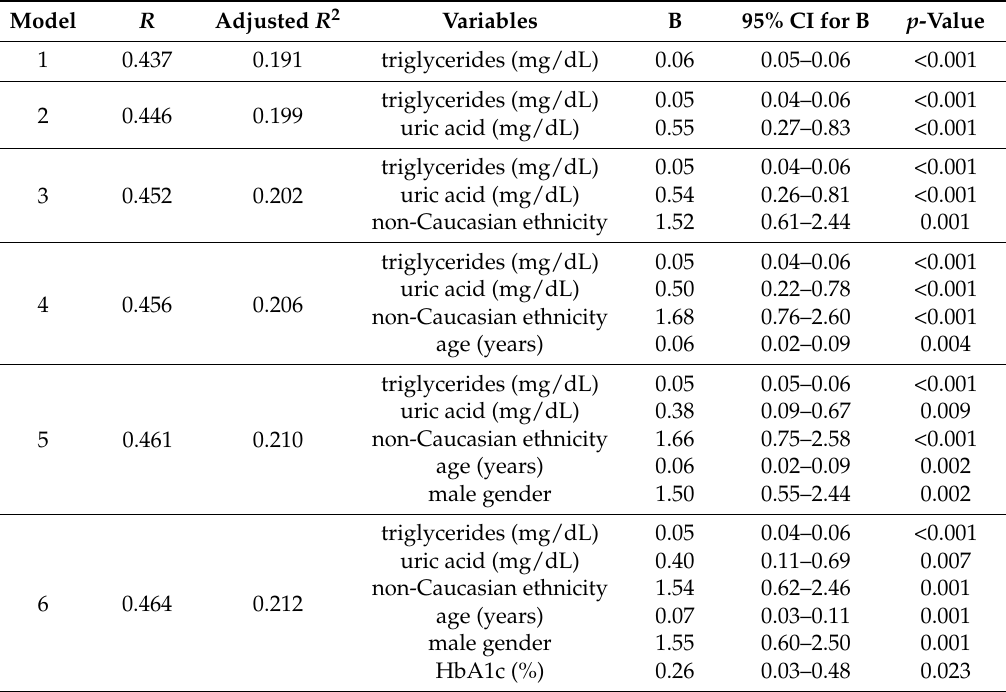
Table 3. Linear regression for predicting ALT